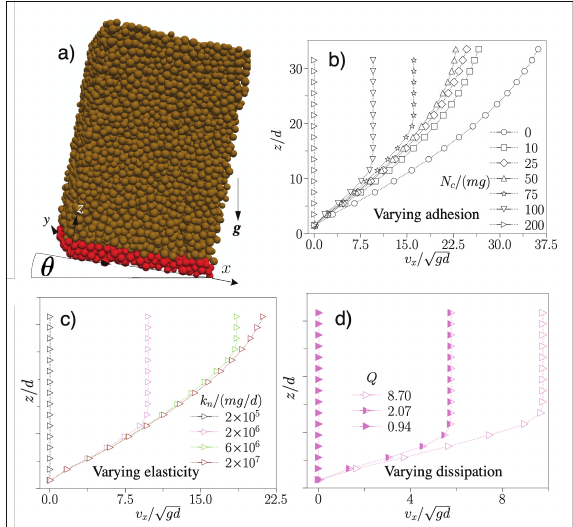
Figure 1. Flow down an inclined plane: (a) sketch of the sim- ulated configuration; velocity profiles for (b) di ff erent adhesion N c ; (c) di ff erent sti ff ness k n ; (c) di ff erent quality factor Q .